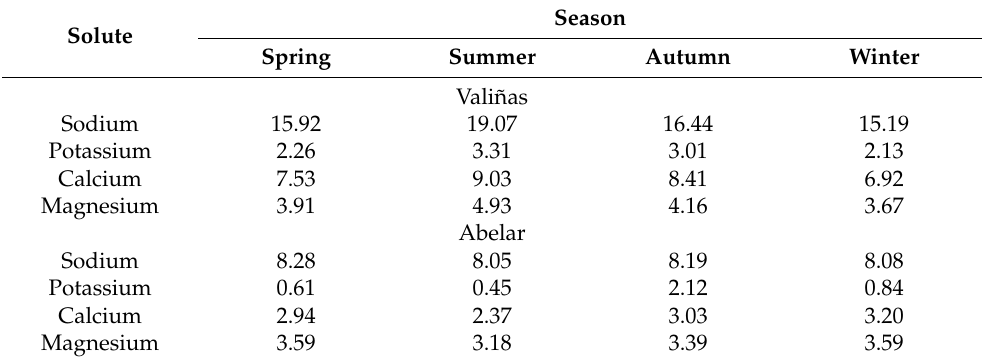
Table 3. Average concentrations (mg L − 1 ) of sodium, potassium, calcium and magnesium on a seasonal basis for the Valiñas and Abelar catchments. Season Solute Spring Summer Autumn Winter Valiñas Sodium 15.92